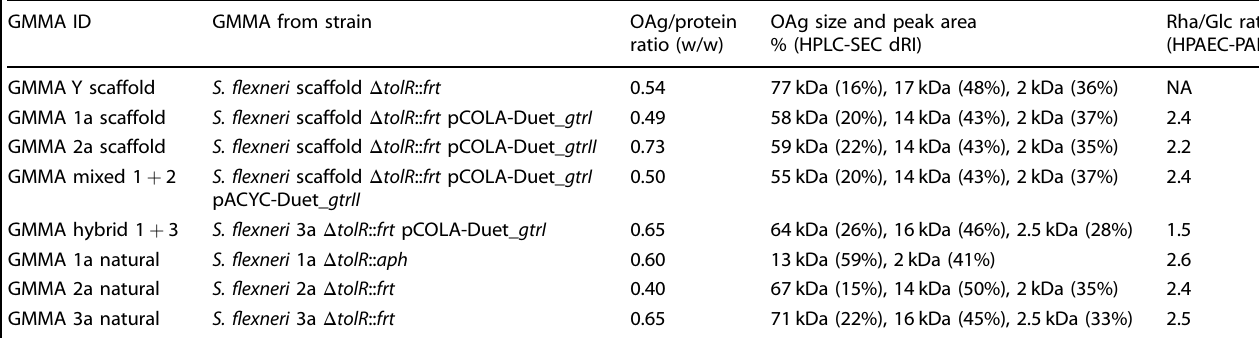
Table 1. Analytical characterization of the GMMA used in the immunogenicity